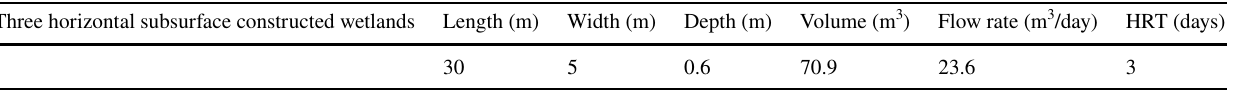
Table 2 Design of three horizontal subsurface flow constructed wetlands (CWs)